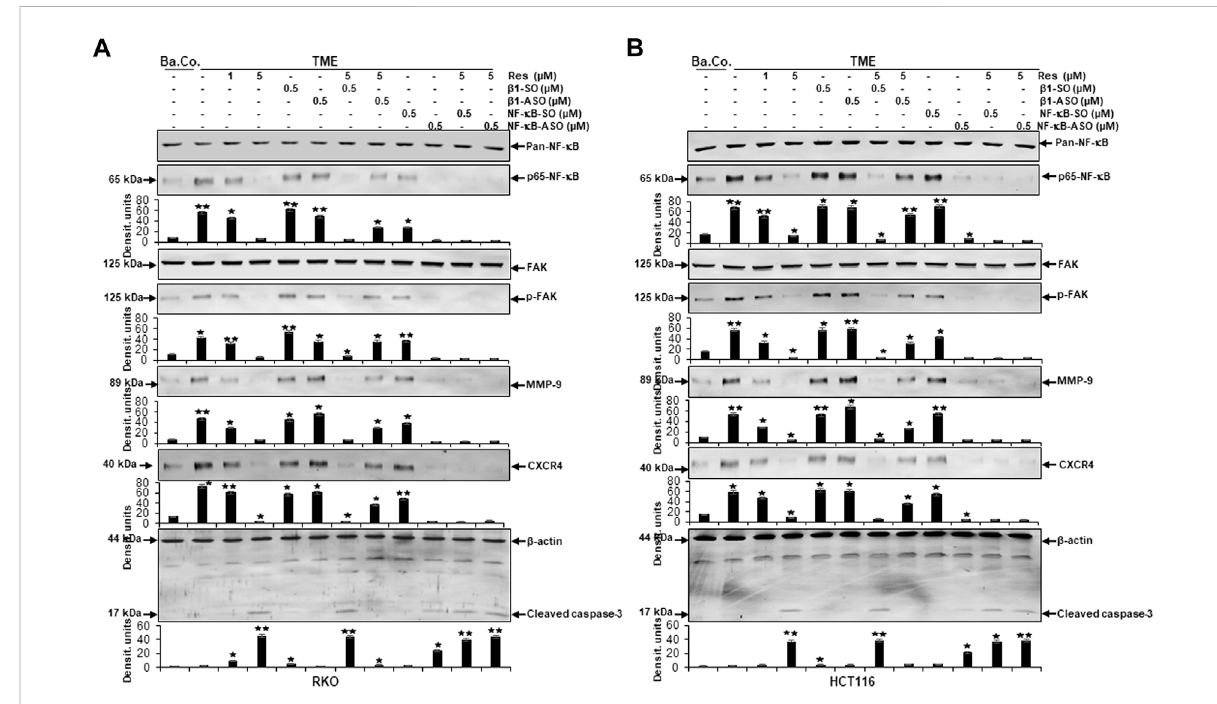
FIGURE 9 Impact of resveratrol or/and ASO against β 1-integrin or against NF- κ B on TME-promoted activation of metastasis- and apoptosis-linked biomarkers in CRC cells. Serum-starved RKO (A) and HCT116 (B) CRC cells, grown in 3D-alginate and differently treated for 10 – 14 days [untreated (Ba.Co.), TME control, resveratrol (1, 5 µM), β 1-SO/ASO (0.5 µM), NF- κ B-SO/ASO (0.5 µM) or combination of 0.5 µM SO/ASO and resveratrol (5 µM); x -axis]wereinvestigatedwithantibodiesagainstpan-NF- κ B,p65-NF- κ B,FAK,p-FAK,MMP-9,CXCR4 andcleavedcaspase-3. β -actinservedas loading control and statistical signi fi cance is shown by: * p < 0.05 and ** p < 0.01 compared with the TME control. Y -axis: Densitometric units ( y -axis) complementing Western blot